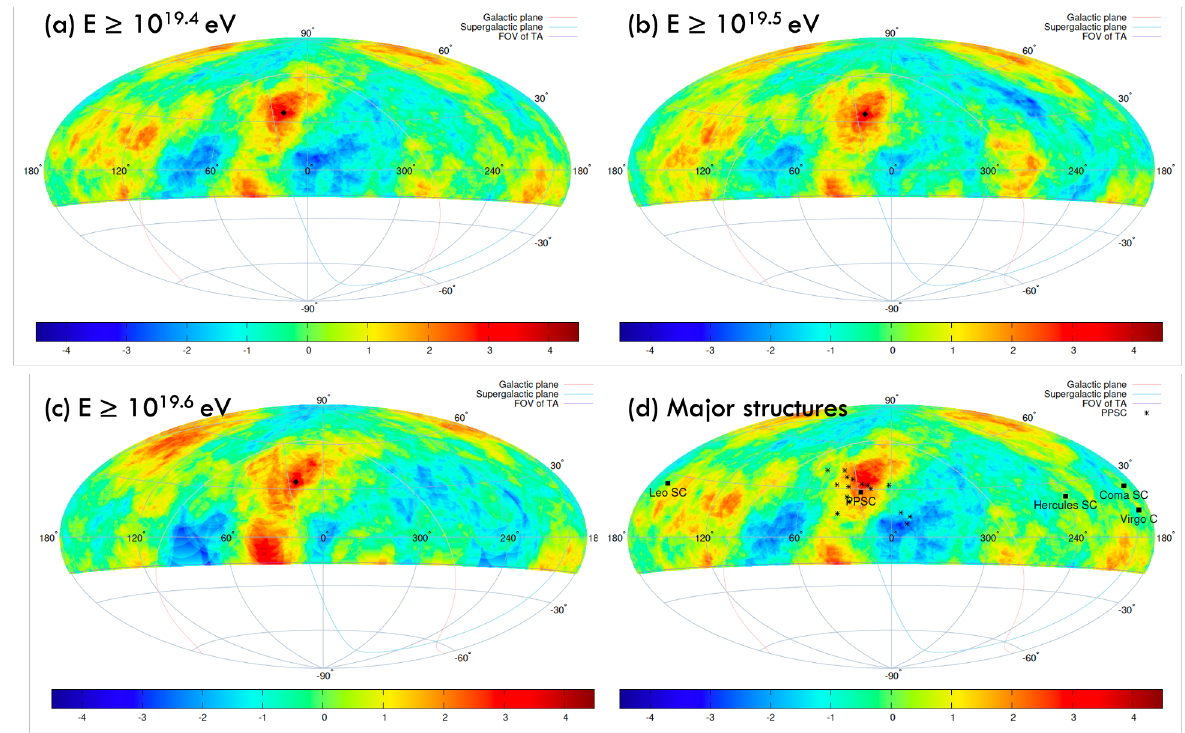
Figure 3. The sky maps of the PPSC excess using Hammer projection. It is shown that the Li-Ma significance using a 20 ◦ -circle angular window in the equatorial coordinates for di ff erent energy thresholds: (a) E ≥ 10 19 . 4 eV, (b) E ≥ 10 19 . 5 eV, and (c) E ≥ 10 19 . 6 eV. In addition, (d) shows the nearby major large-scale structures with the Li-Ma significance map with E ≥ 10 19 . 4 eV. The color code indicates an excess (red) and a deficit (blue) of events compared to isotropy at each grid